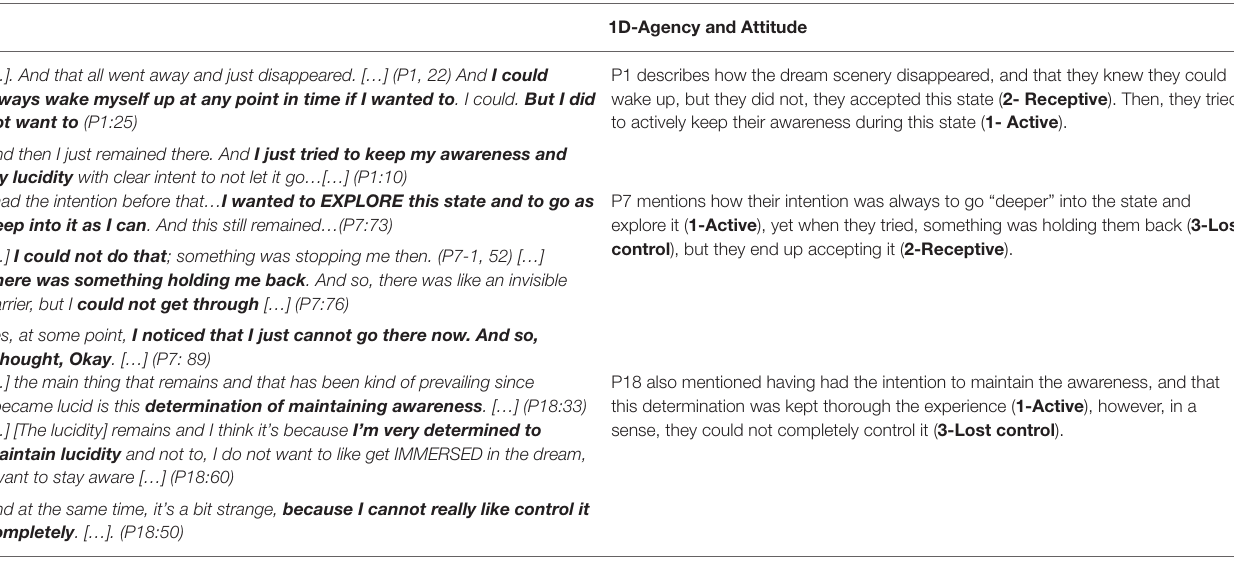
TABLE 5 | Quotes characterizing the dimension of “ 1D-Agency and Attitude ” for three of the participants alluding to more than one third-level category in their descriptions (P1, P7, and P18) during the “nothingness phase.” 1D-Agency and Attitude